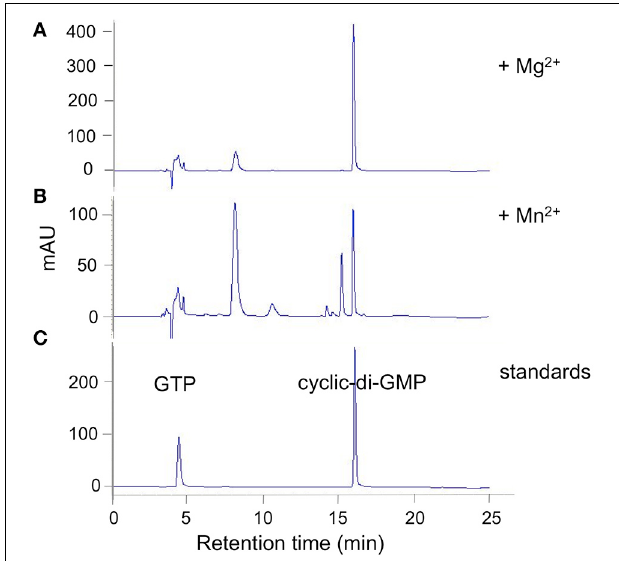
FIGURE 2 | DVU0636 has DGC activity. HPLC traces for DGC activity assays with purified DVU0636 (with C-terminal V5 epitope and 6 × His tags) and 500 μ M GTP in the presence of 2mM MgCl 2 (A) , or 2mM MnCl 2 (B) . 100 μ M GTP and 100 μ M c-di-GMP were used as standards (C) .